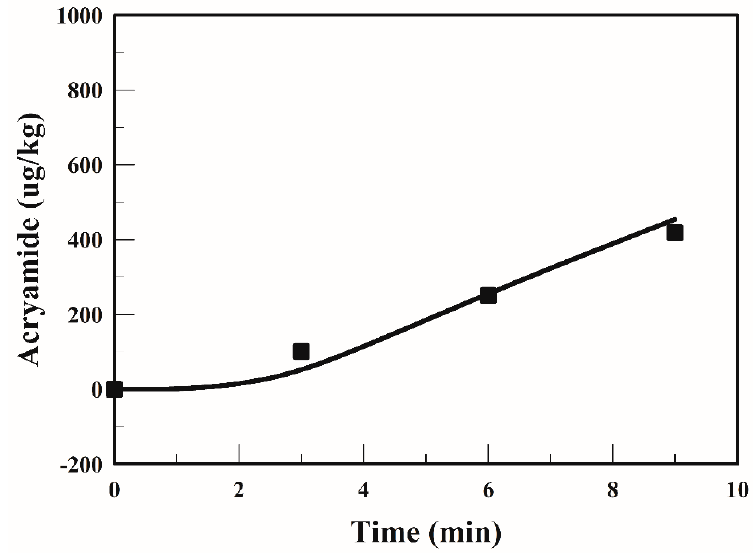
Figure 4. Average acrylamide formation in the strip at 170 °C. The symbol represents the experimental data obtained [20]; the line represents the simulated values.